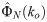
Plots showing stability and forecast analysis with varying Φ^N(ko) and λ.a) Model is stable when S~=1 for ΦN(ko) < 1. b) Forecast plots for varying PPD with fixed λ = 0.5. PPD > 1 leads to exaggerated forecasts (dotted red plot), low PPD causes underestimated or linear forecasts (solid and dotted dark orange), and larger PPD provides nonlinear forecasts (dark green). c) (i) Input (ΔUN) and output (ΔF^N) plots satisfying Stability Condition 1, and (ii) constant PPD indicates validity of Eq (10). d) Increase in PPD decreases FI which makes forecasts more nonlinear. e) RMSE is low for linear forecasts at F (PPD = 0.01), and underestimated forecasts at B (PPD-0.001). However, RMSE was lowest for PPD = 0.5 at (A,D,E). f) FI increases with λ causing underestimated forecasts. λ ≤ 1 for nonlinear forecasts.